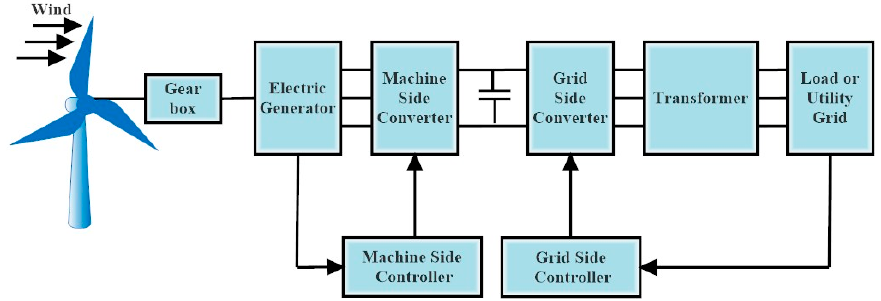
Figure 4. Block diagram of a typical grid-connected WECS.